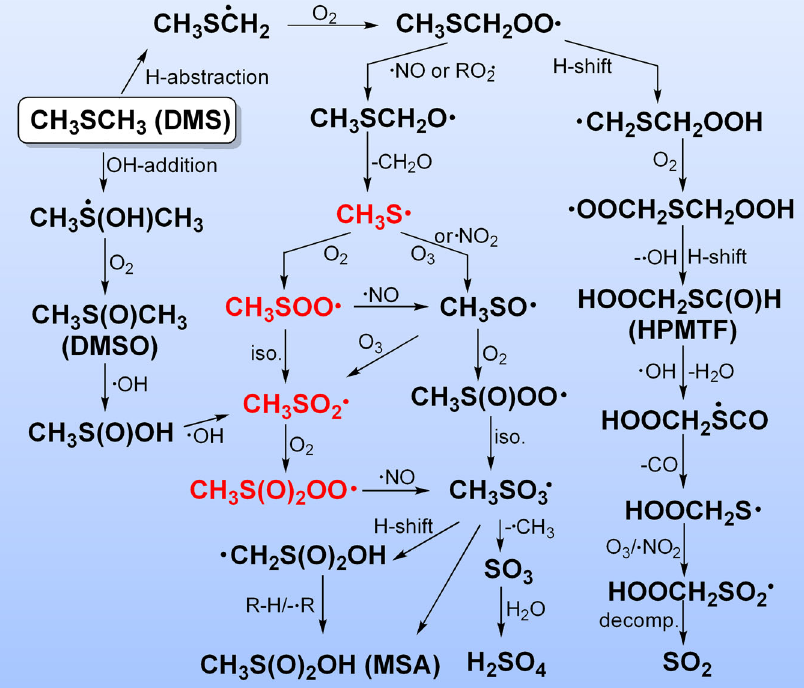
Fig. 1 Reaction pathways for the atmospheric oxidation of dimethyl sul fi de (DMS). The reaction pathways for the formation and subsequent O 2 - oxidation of methylthio radical (CH 3 S (cid:129) ) during the atmospheric oxidation of dimethyl sul fi de (DMS). Radicals studied in this work are shown in